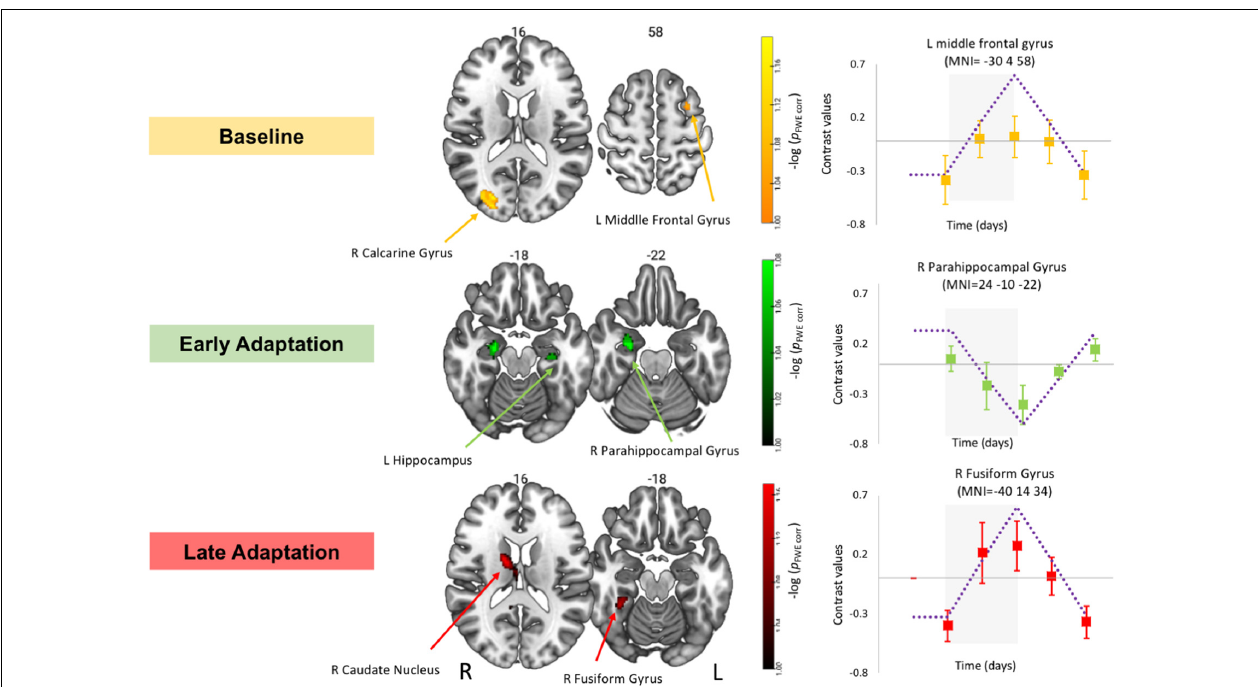
FIGURE 4 | Time course of the neural visuomotor adaptation response to HDBR+CO 2 . Left: Whole brain results showing increases in activation during the baseline (yellow) and late phases of adaptation (red) and decreases in activation during early adaptation (green) followed by recovery. Whole brain results are overlaid onto an MNI standard template, thresholded at FWE < 0.10 and k = 10 voxels. The color scale depicts the -log( p FWE-corr ) values in which brighter colors (higher values) represent smaller p values. Right: Example contrast values plotted for peak coordinate within the cluster with the smallest p -value in each case. Squares represent group mean contrast values; error bars represent standard error. Purple dotted lines show the hypothesized longitudinal contrasts for “cumulative decrease” and “cumulative increase” during-HDBR+CO 2 followed by recovery. Gray box represents the intervention time in days. TABLE 1 | Brain regions showing longitudinal increases and decreases in activation during visuomotor adaptation. TFCE-level MNI coordinates (mm) Extent (k E ) p FWE-corr Contrast values x y